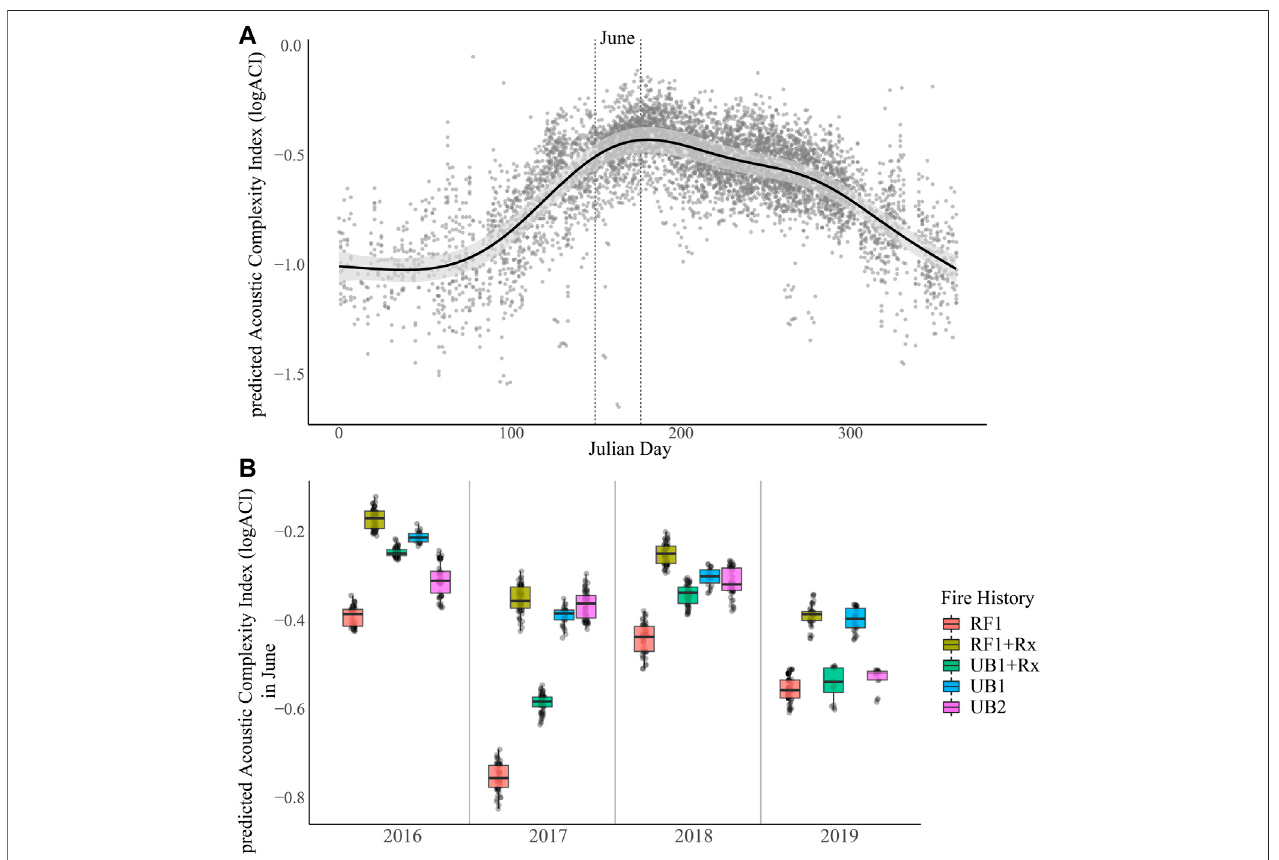
FIGURE 3 | Seasonal effects on Acoustic Complexity Index. (A) Predicted relationship between ACI and Julian day across all sites and years showing increase in ACI in the month of June. (B) Comparison of predicted ACI in the month of June — the peak period in avian ecoacoustic activity — across all years and within each fi re history category. RF1 = burned by the Rough Fire without a prescribed fi re history in old growth forest; RF1 + Rx = burned by the Rough Fire with prior prescribed fi re in oldgrowthforest;UB1+Rx=unburnedbytheRoughFirebutwithpriorprescribed fi reinoldgrowthforest;UB1=norecorded fi rehistoryinanoldgrowthsequoia forest; UB2 = no recorded fi re history in a second-generation sequoia forest.